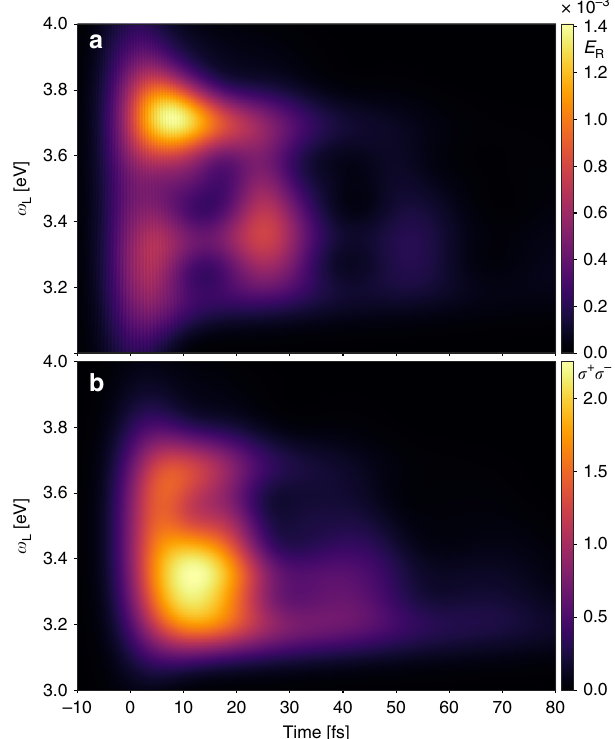
Fig. 2 Time-dependent radiative emission. Mean values of the time- dependent radiative emission, E R , ( a ) and 〈 σ + σ − 〉 ( b ) for different values of ω Ω = 0.4 eV. For all calculations, E L and for R 0.1